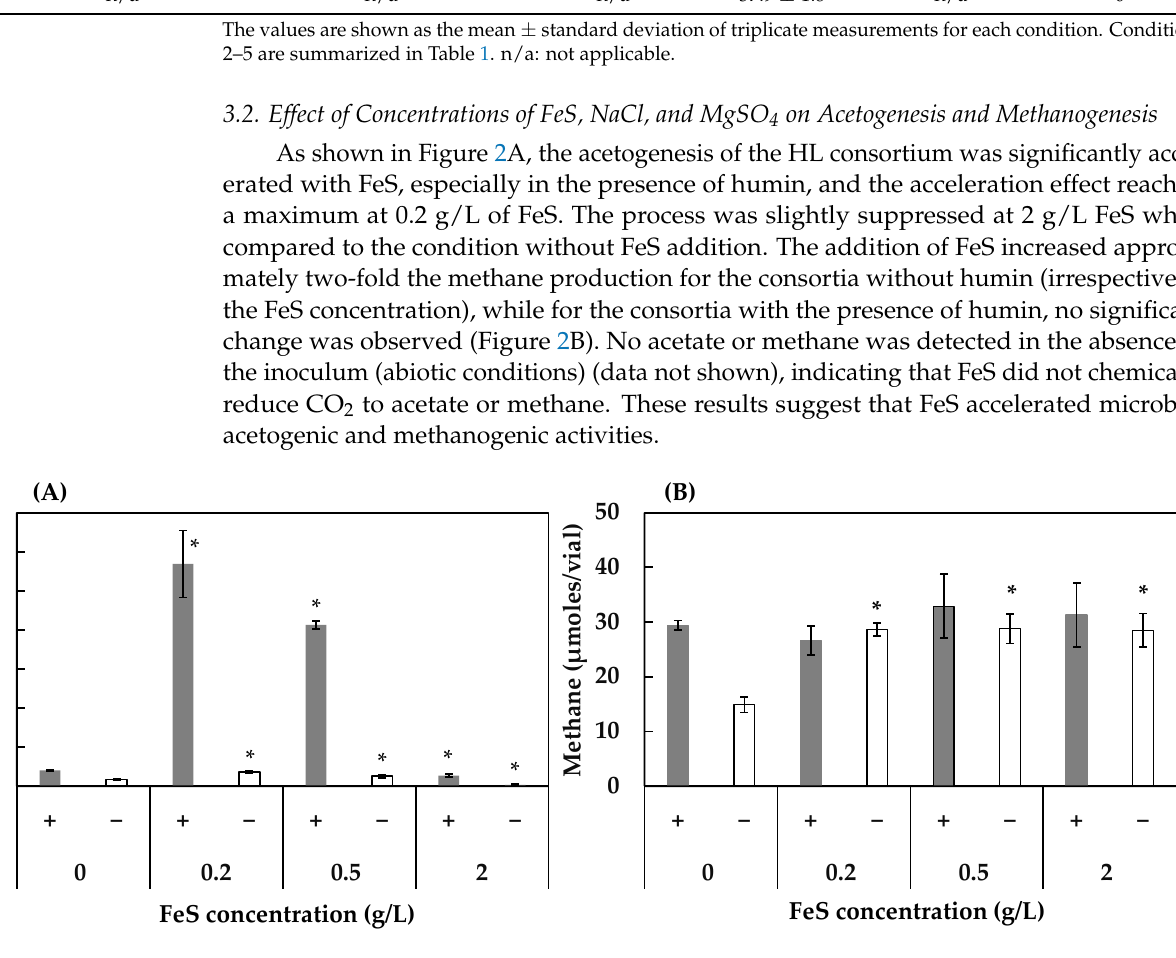
Figure 2. Effect of FeS concentration on the production of acetate ( A ) and methane ( B ) in the HL consortium in the presence (+) and absence ( − ) of humin. The conditions with 0 g/L of FeS are the same as conditions 4 (with humin) and 2 (without humin) in Figure 1. Vertical bars represent the standard deviation. The acetate and methane production with various FeS concentrations were statistically compared with those of 0 g/L of FeS using the independent t -test. * represents a significant difference at p < 0.05.